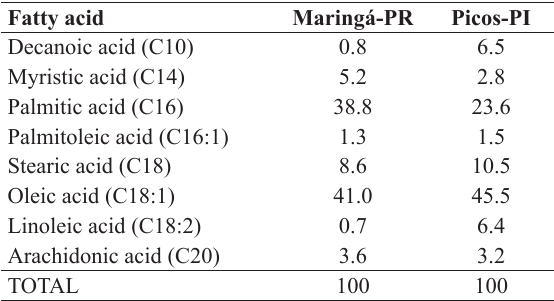
Fatty acid percentage in seeds of mandacaru from Maringá and Picos